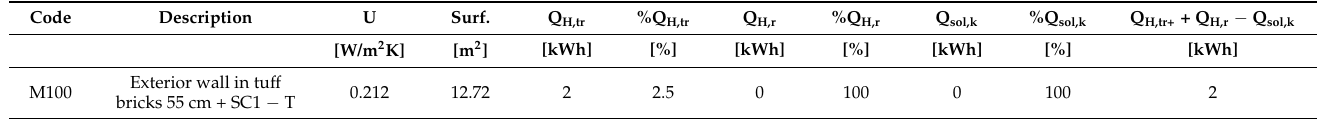
Table 8. Dispersions through the M100 component: post operam monitoring period; climatic zone